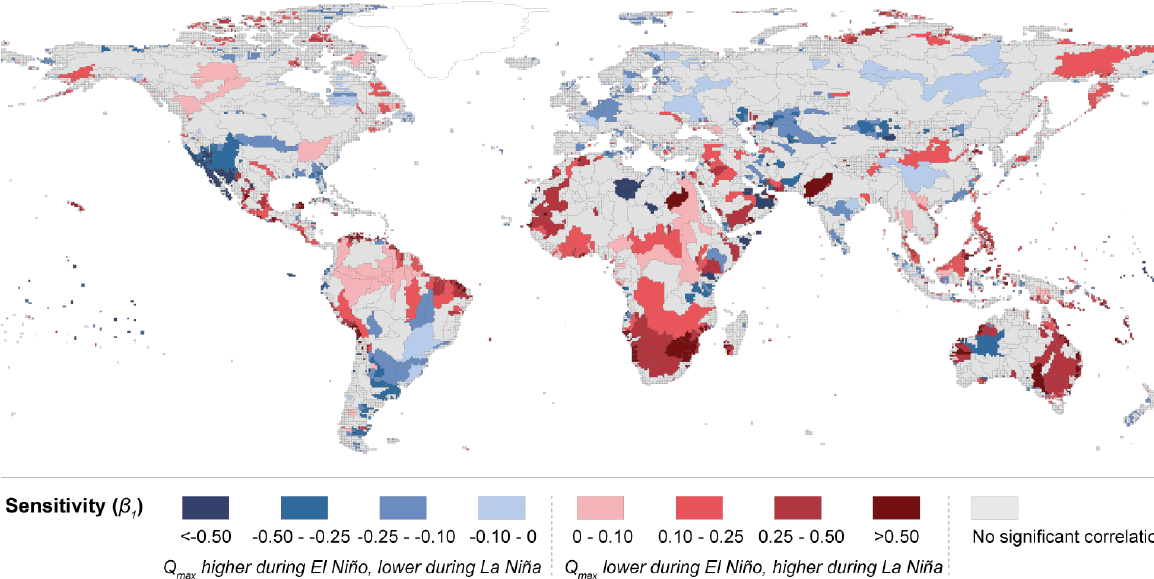
Fig. 4. Sensitivity ( β 1 ) of ln Q max to variations in SOI. Sensitivity is only shown for basins with significant correlation at a 10% confidence interval (Pearson’s r , t statistic, α = 0 . 10). Negative correlation generally represents higher annual floods in El Niño years/lower annual floods in La Niña years, while positive correlation generally represents lower annual floods in El Niño years/higher annual floods in La Niña